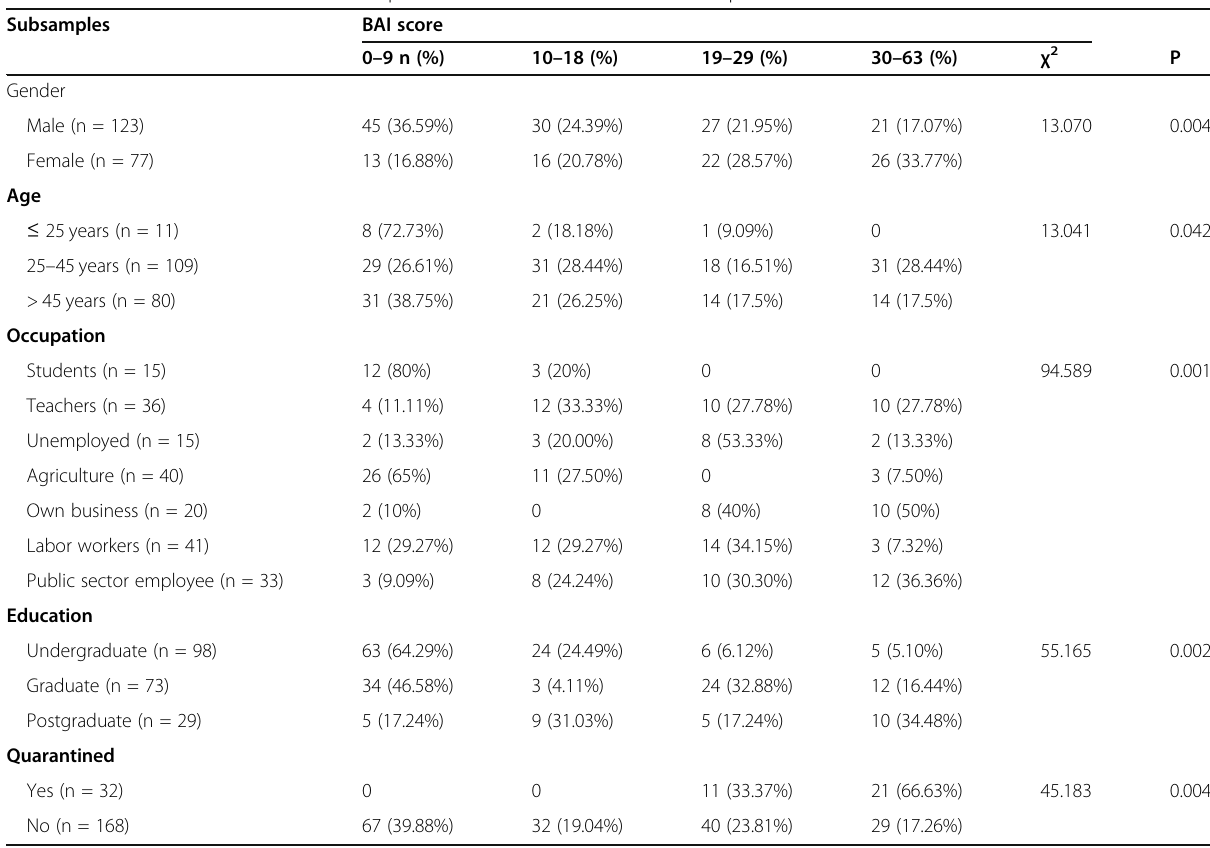
Table 2 BAI score of the HCV-infected respondents classified in various